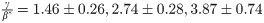
Variation of the initial damage pattern and tissue size.(A-C) Fixed tissue length (N = 10) with Hi = 2 (A), Hi = 4 (B) and Hi = 8 (C) with α = 5 (hours). Lines are drawn through points where survival probability drops to 0.95±0.01. Values of γ/β* = 0.38±0.11, 1.07±0.18, 2.53±0.35 (A-C). (D-F) Fixed damage fraction (≅40%) with different tissue lengths of N = 8, 16, 24. Approximate slopes are γβ*=1.46±0.26,2.74±0.28,3.87±0.74. (G) Combined curves showing the slope boundaries for different fractions of damage with different tissue lengths. (H) Rescaling the slopes by the tissue lengths collapses the curves.